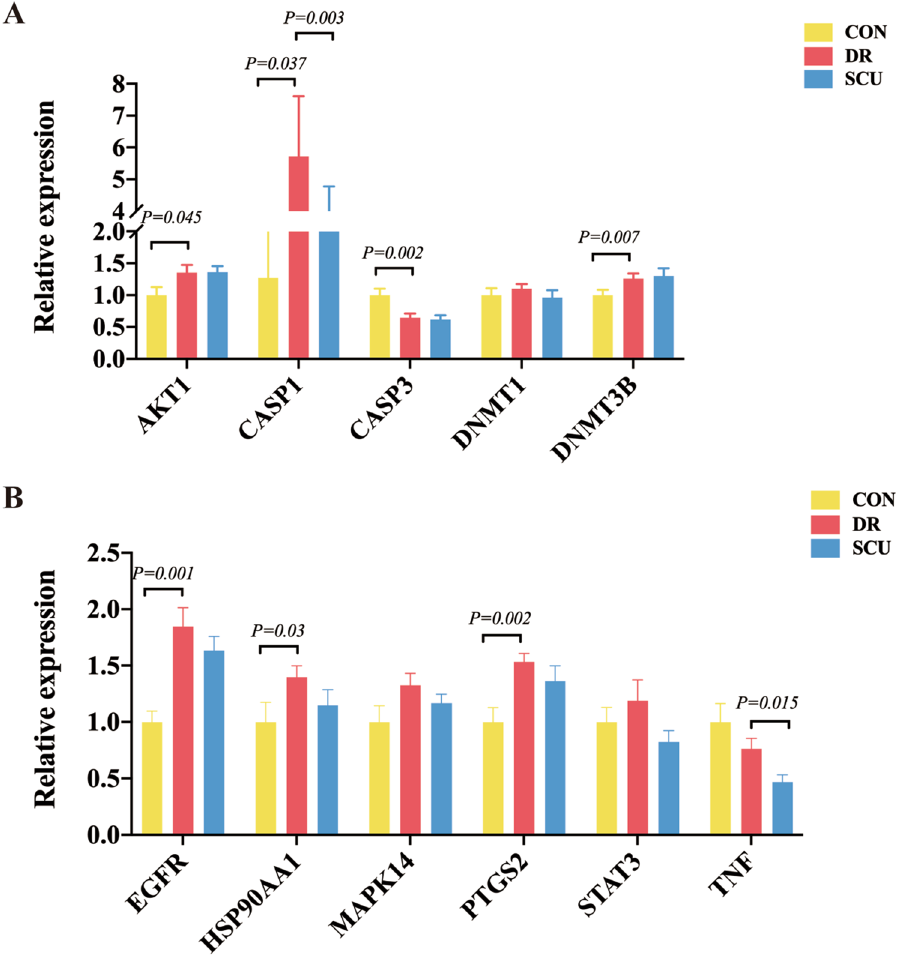
Figure 9. qRT-PCR. ( A ) The relative mRNA expression of AKT1, CASP1, CASP3, DNMT1 and DNMT3B in the control, DR and SCU group. ( B ) The relative mRNA expression of ERFG, HSP90AA1, MAPK14, PTGS2, STAT3 and TNF in the control, DR and SCU